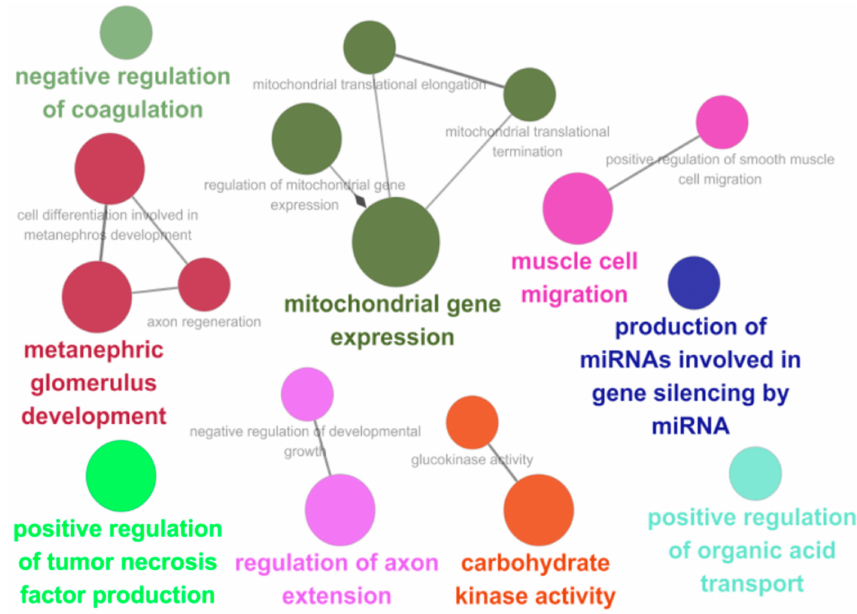
Figure 2. Functional annotation of union PSGs. The gene ontology network was constructed by ClueGO [38] with PSGs under FDR< 0.1, 2 ∆ L >0, and ω 2